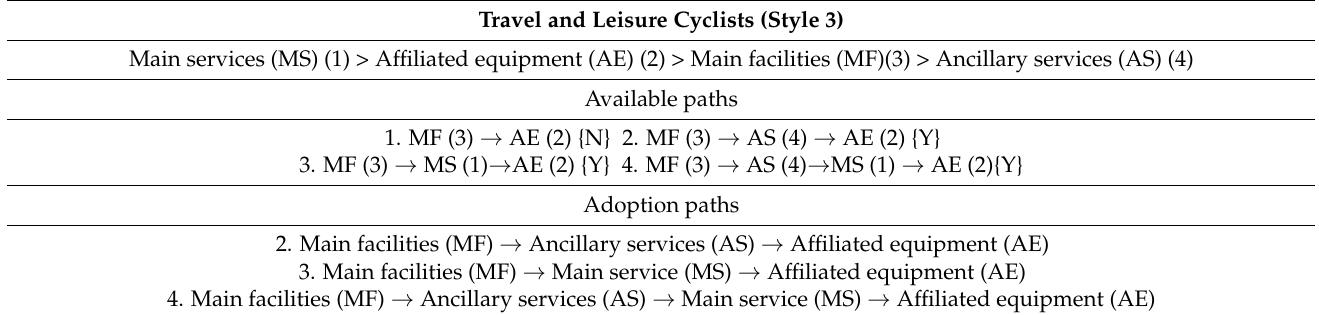
Table 22. The adoption paths of travel and leisure cyclists (Style 3).